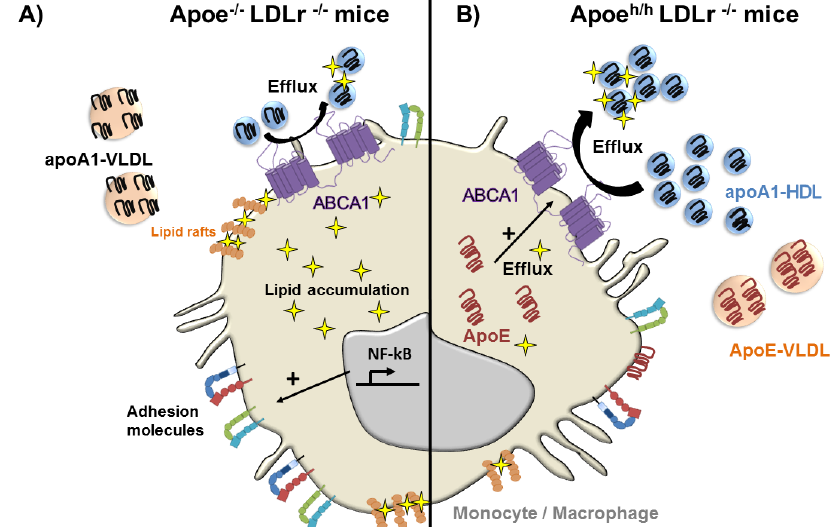
Figure 3. ApoE reduces lipid accumulation and the activation of monocytes and macrophages in hyperlipidemic mice. ( A ) In the absence of apoE, apoA1 distributes to both VLDL and HDL